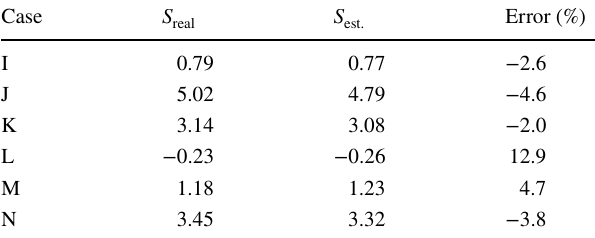
Table 5 Estimated reservoir mechanical skin for the multilayer